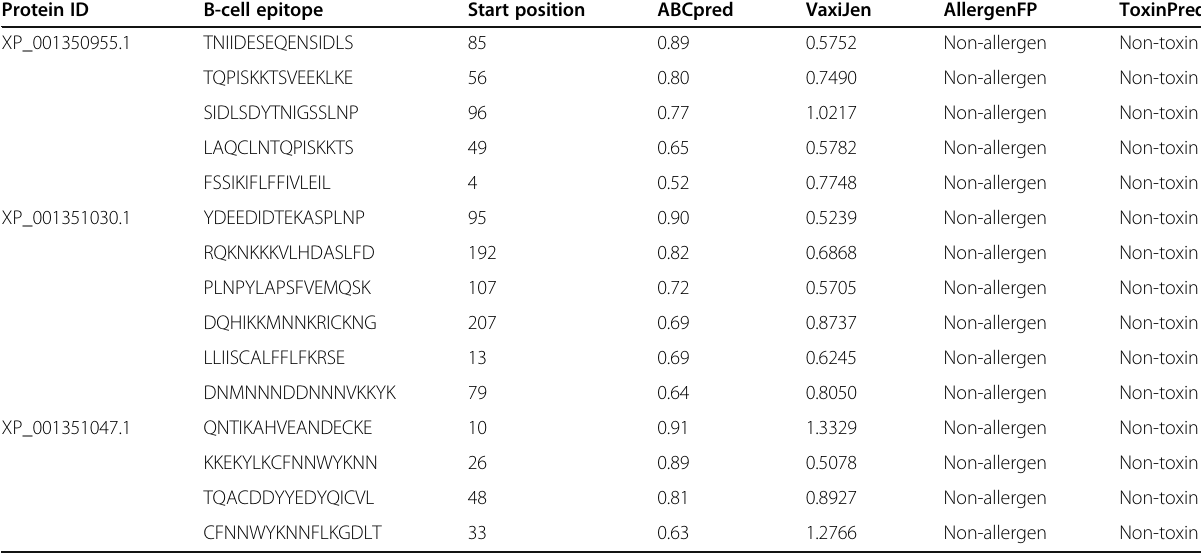
Table 4 Final list of potential B-cell epitopes of the three selected hypothetical proteins of Plasmodium falciparum Protein ID